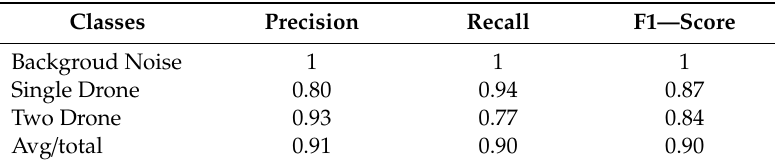
Table 4. Classification Report for CoNN with Wigner-Ville